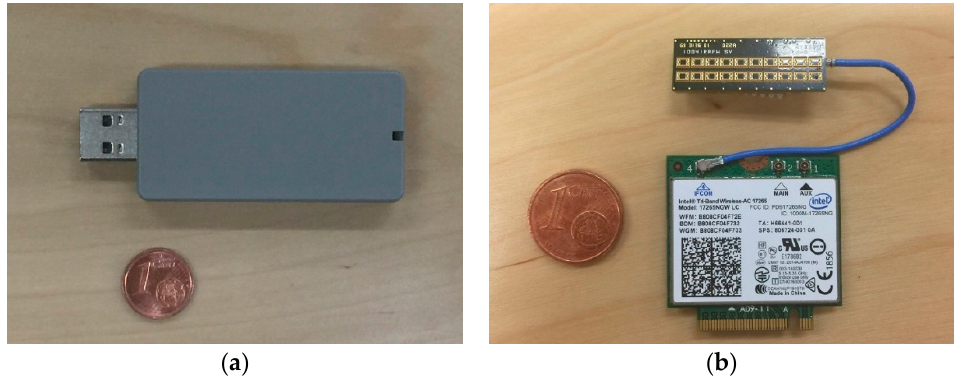
Figure 2. IEEE 802.11ad/WiGig communication devices: ( a ) Panasonic ® WiGig-USB dongle: 60-GHz antennas, RF, PHY and MAC components are bundled into one package. Universal Serial Bus (USB)-3.0 is used as the interface to higher layer processors, such as a personal computer (PC). ( b ) Intel ® Wireless Gigabit Antenna module (top) and Intel ® Tri-Band Wireless-AC 17265 WiGig and Wi-Fi + Bluetooth combination module [52] (bottom). The antenna module contains a beamforming phased antenna array (PAA) of 10 × 2 elements (8 × 2 active elements, 8 in azimuth and 2 in elevation).